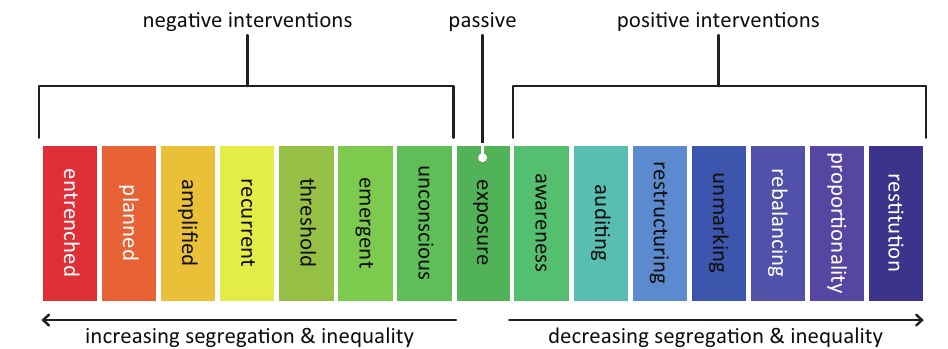
Figure 5. Conceptual “litmus test” framework following expert panel workshops.